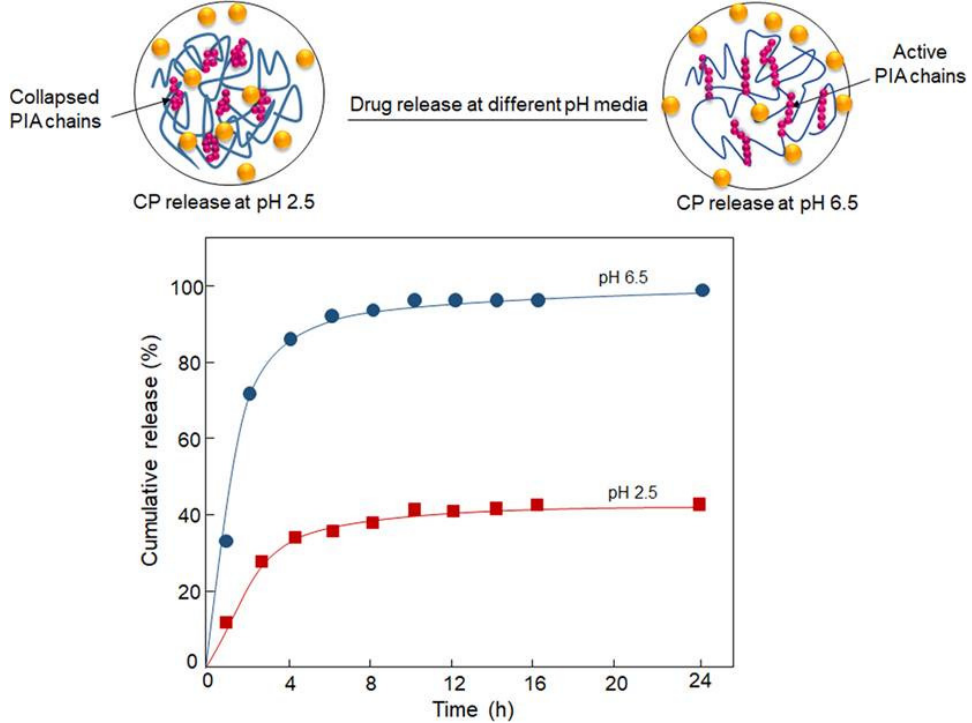
Figure 19. In vitro cisplatin release from nanoparticles at pH = 2.5 and 6.5. Reproduced from [158] with permission.